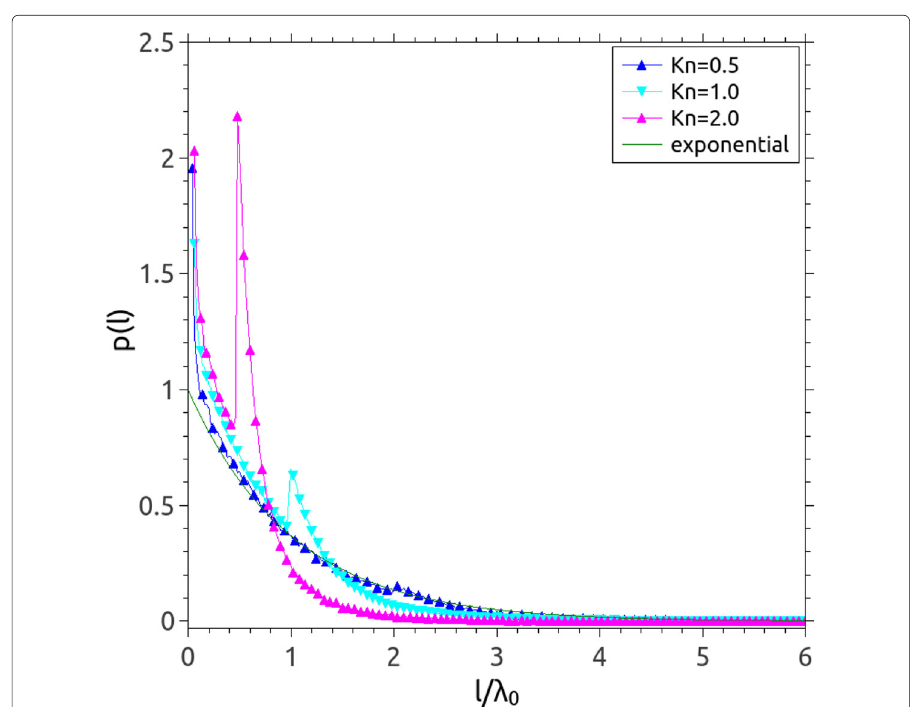
Fig. 3 Probability density distribution of the individual free paths of gas molecules in channels with heights decreasing from 2 λ 0 to λ 0 /2, corresponding to Kn increasing from 0.5 to 2.0. The green solid line is the exponential